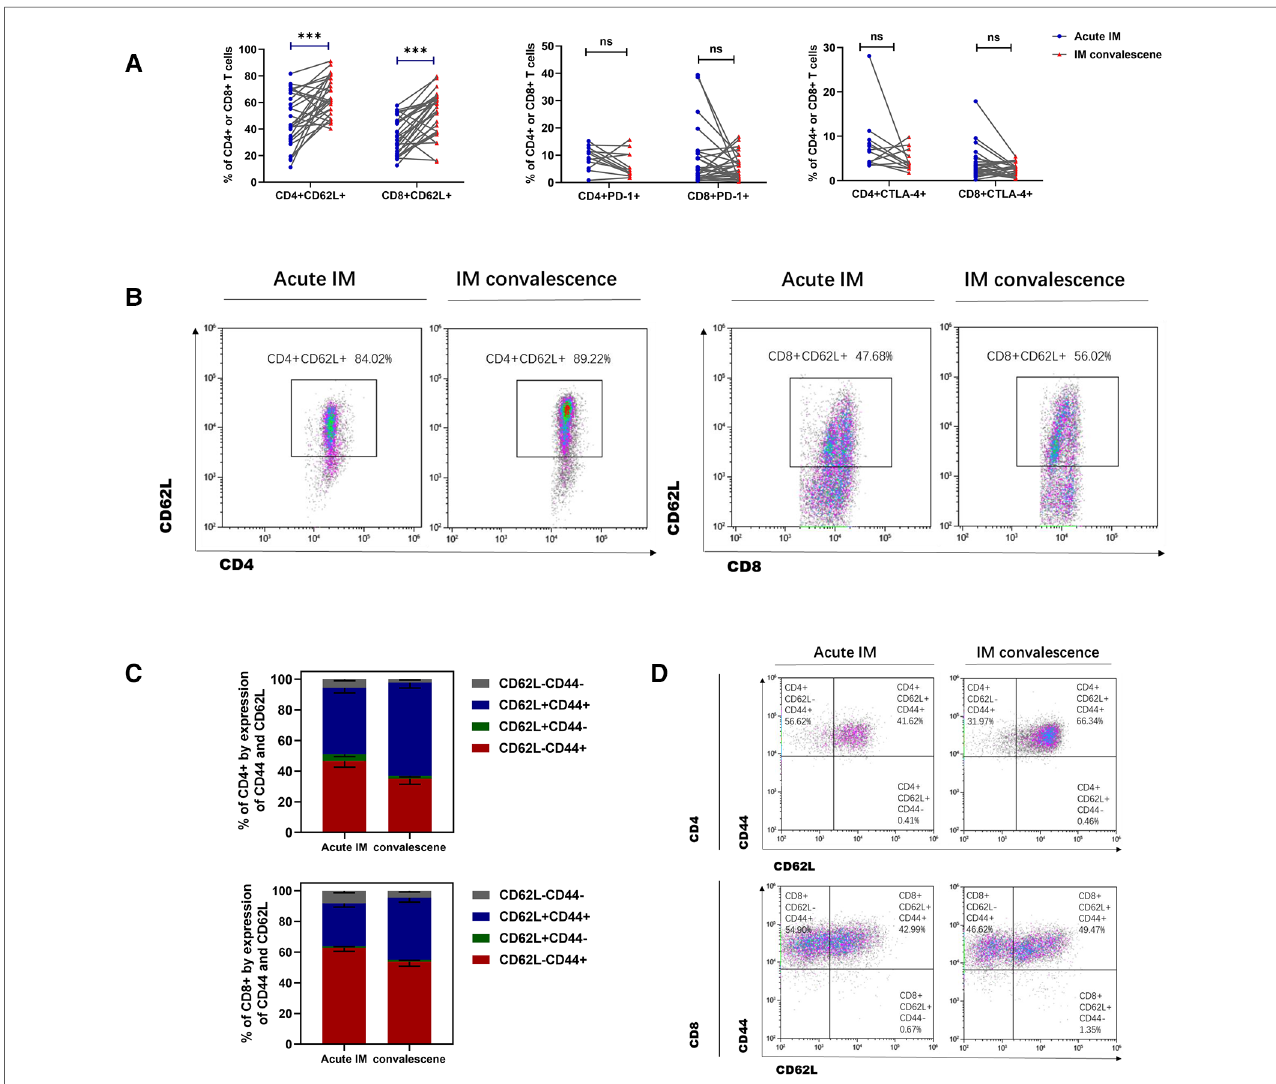
FIGURE 6 Analysis of T cells immunophenotype in IM patients after anti-viral therapy. ( A ) The expression of CD62L, PD-1and CTLA-4 on CD4 + T and CD8 + T cells was analyzed between the acute and early convalescent phases of the IM disease. ( B ) Representative dot plots showing the CD62L expression on CD4 + T and CD8 + T cells. ( C,D ) The frequencies of different subsets of CD8 + T cells and CD4 + T cells indicated by the CD44 and CD62L expression. Data are expressed as the means±SD. *** P